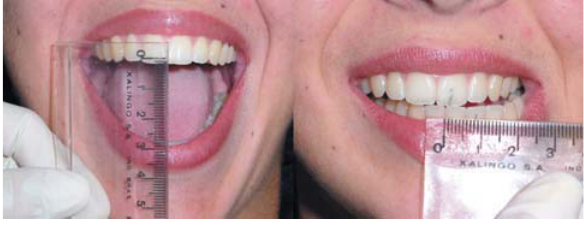
FIGURE 4- Palpation of anterior and posterior temporalis muscle